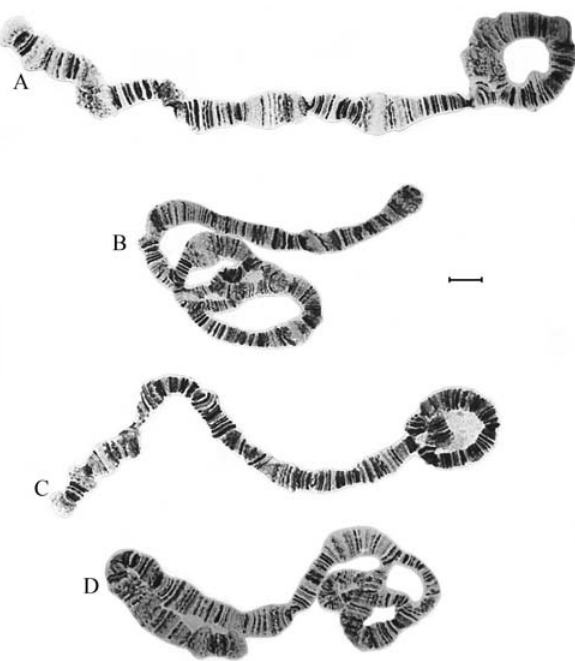
Figure 8 - Heterozygous arrangements observed in Drosophila arassari chromosome 2. A: heterozygous inversion 2e; B: heterozygous resulting from pairing of the homozygous inversion 2g with the standard sequence of D. arassari ; C: heterozygous inversion 2f; D:heterozygous resulting from pairing of the homozygous inversion 2e with the homozygous inver- sion 2f. Scale bar = 10 μ m.